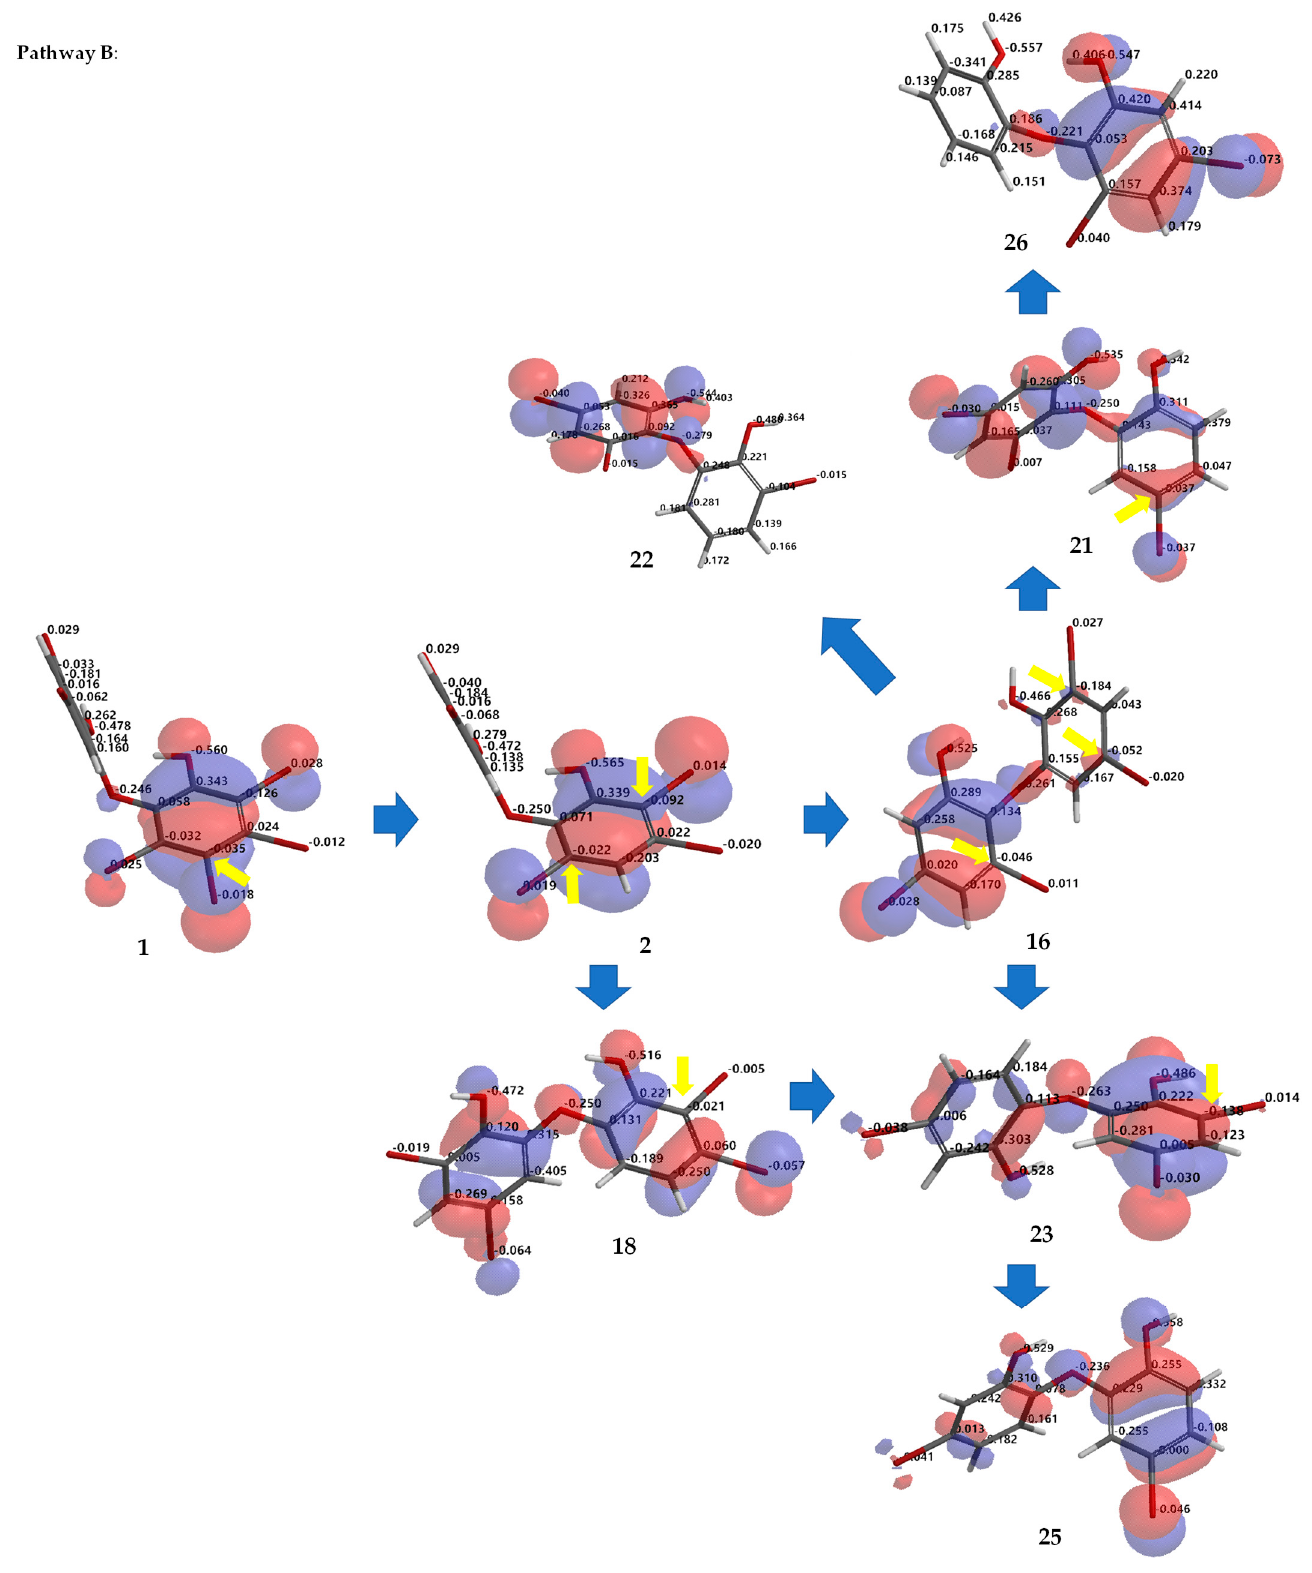
Figure 7. Figure 7. Cont.